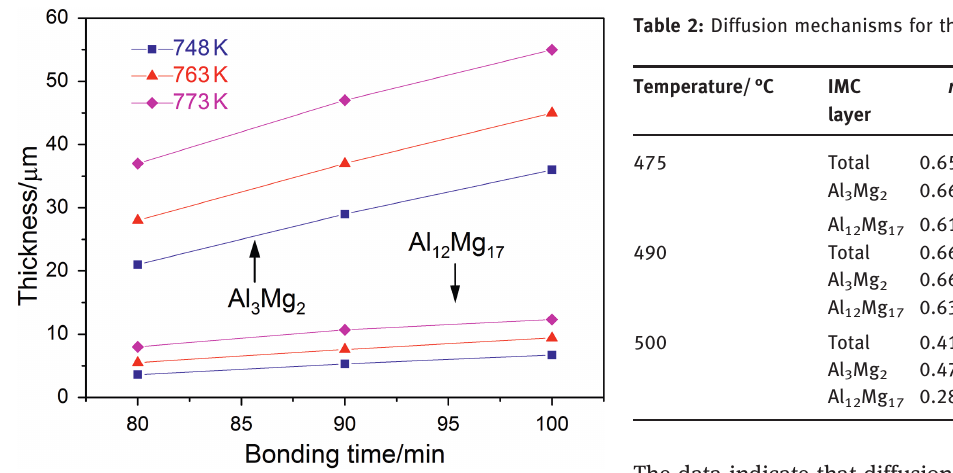
Figure 10: Thickness of IMCs for different time at elevated temperatures. The thicknesses of IMCs from the joint interface bonded at different predominant process parameters are pre- sented in Figure 10. Thickness of IMCs is increasing with welding temperature and holding time, the growth of IMCs layer can be attributed to the interdiffusion of Mg and Al atoms.